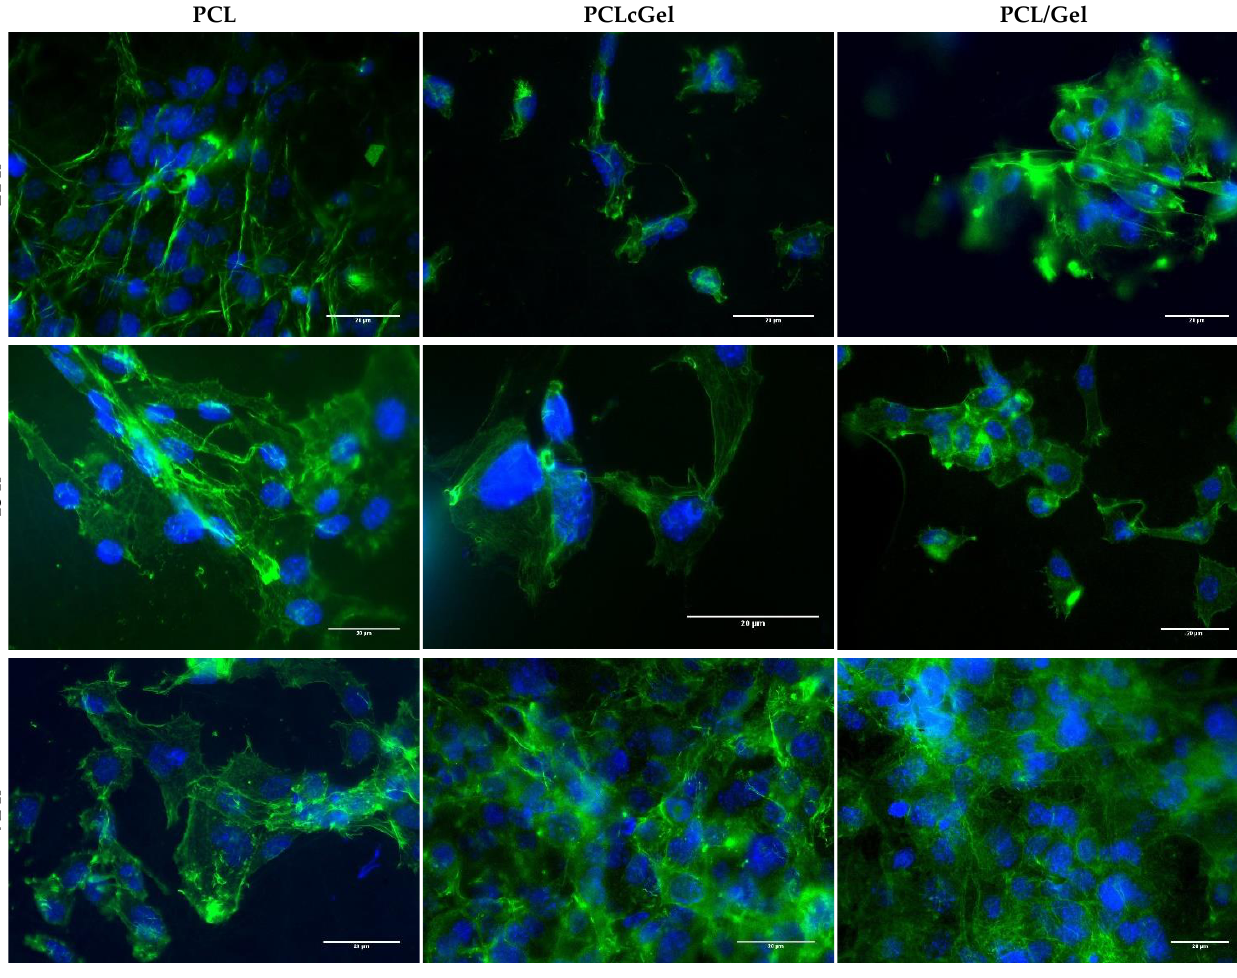
Figure 7. MEF proliferation study on the PCL, PCL gelatin coating and PCL/gelatin blend for 24, 48 and 72 h. (Green) Actin filaments of MEF stained with Phalloidin AlexaFluor 488. (Blue) DAPI staining the nucleus. Scale bar: 20 μm.